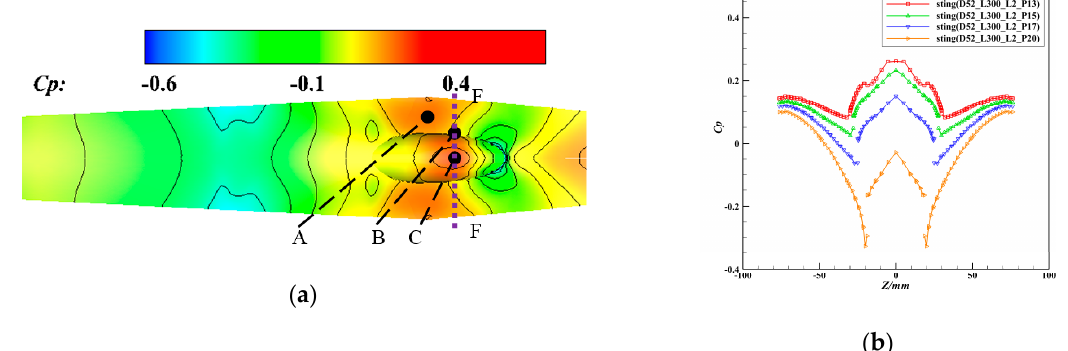
Figure 12. Support interference results of the BWB aircraft with different inflection angles (P = Figure 13. Pressure contour and distribution of the BWB aircraft with different inflection angles (P = 13°/15°/17°/20°, Ma = 0.75, α = 0°): ( a ) pressure contour of the BWB aircraft under the P = 13° condition; ( b ) pressure distribution of profile F-F (position of F-F is shown in Figure 13a).